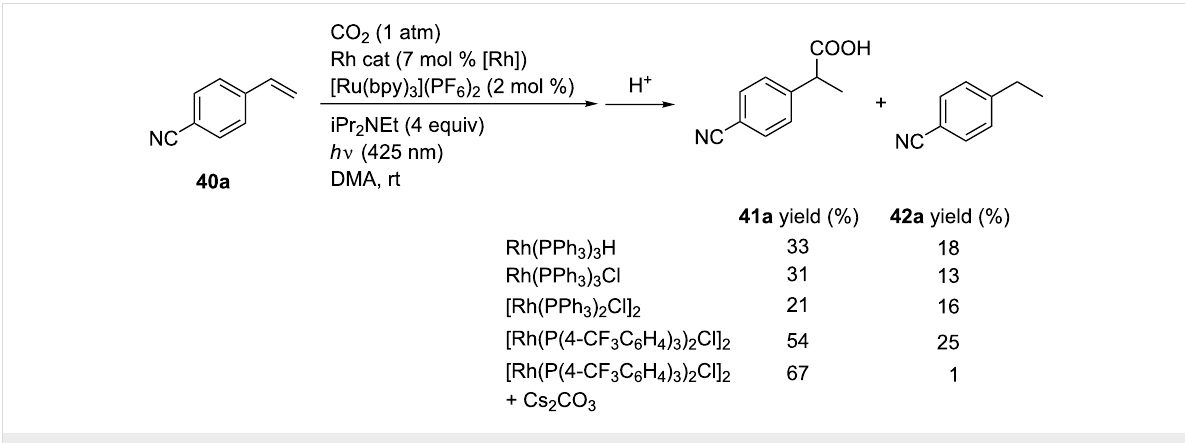
Scheme 37: Visible-light-driven hydrocarboxylation with CO 2